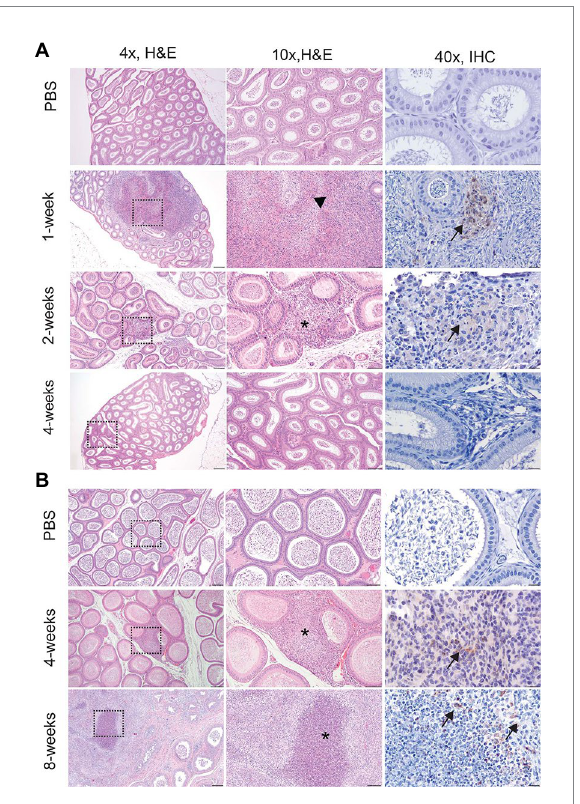
FIGURE 4 Infection with 16 M B. melitensis disrupts spermatogenesis in the guinea pig. Testicle from mice (A) at the peracute (1- and 2-week p.i.) and acute (4-week p.i.) and guinea pigs (B) at the acute (4- week p.i.) and chronic (8-weeks p.i.) stages of infection following IT inoculation with 10 7 B. melitensis . No lesions were detected in the mouse at any stage of infection. The lesion in guinea pigs at 8-weeks consisted of a focally extensive area of necrosis with macrophages and neutrophils (yellow arrow). Adjacent seminiferous tubules were degenerate (*) with disrupted spermatogenesis. Macrophages were positive for Brucella antigen by IHC (black arrow). Tissues were stained with hematoxylin and eosin (H&E) and a polyclonal Brucella antibody (IHC) at 1:500 with Gill’s hematoxylin counterstain. Dashed box of 4x image indicates area highlighted for the 10x and 40x images. 4x, scale bar = 100 μ m; 10x, scale bar = 50 μ m; 40x, scale bar = 10 μ